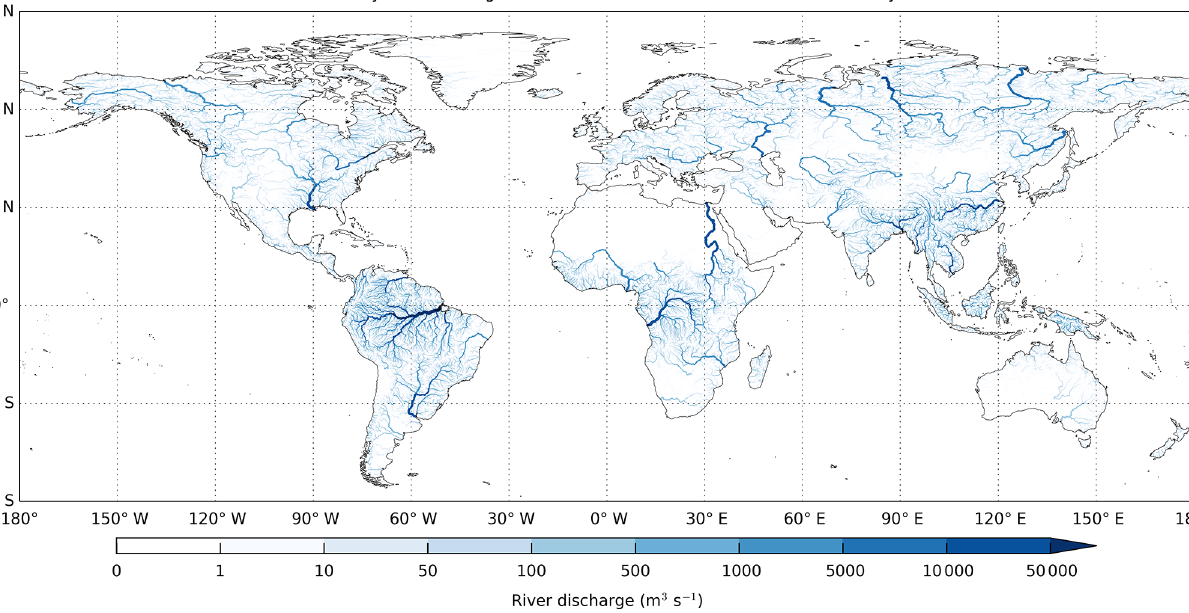
Figure 2. Mean GloFAS-ERA5 daily river discharge from 1979 to 2018 for each GloFAS river grid cell with an upstream area greater than 1000km 2 . Darker blue river sections have larger river discharge.